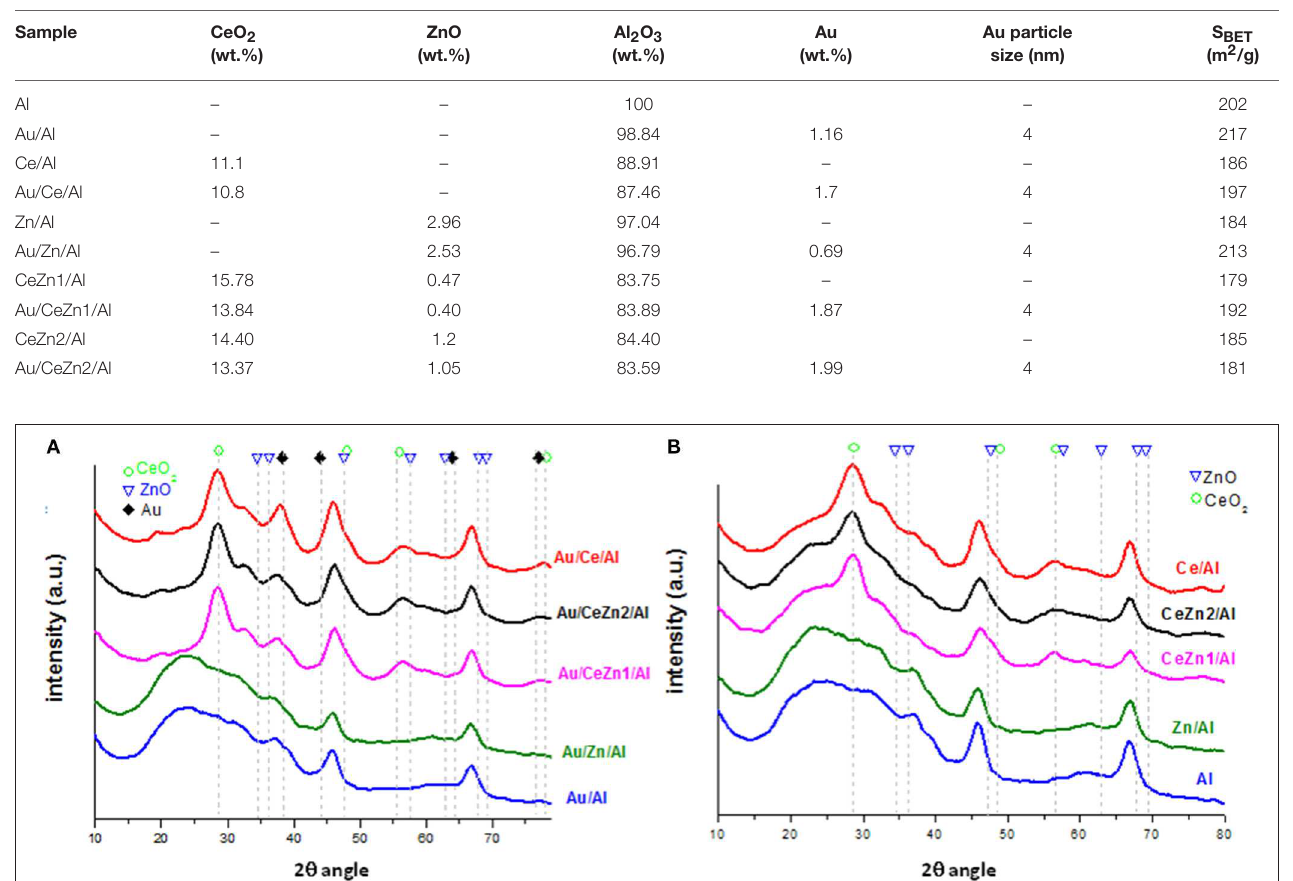
FIGURE 1 | XRD patterns of (A) gold catalysts and (B) parent